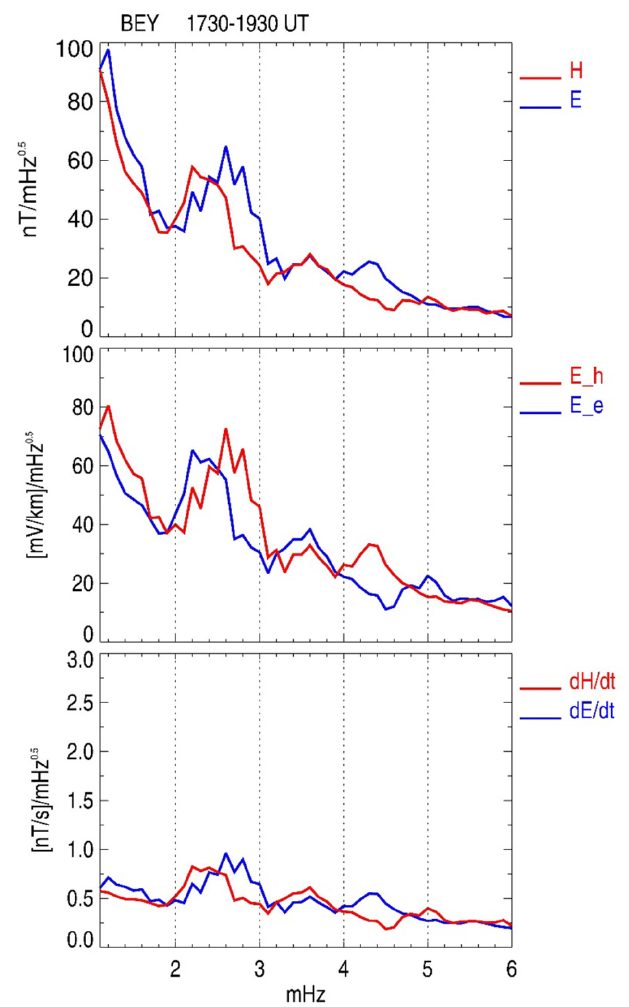
Figure 7. The amplitude spectra of horizontal magnetic ( H and E components) and telluric ( E H and E E components) field variations at station BEY during the 6 January 2019 event. Bottom panel shows the spectra of the magnetic field variability d H /dt and d E /dt.